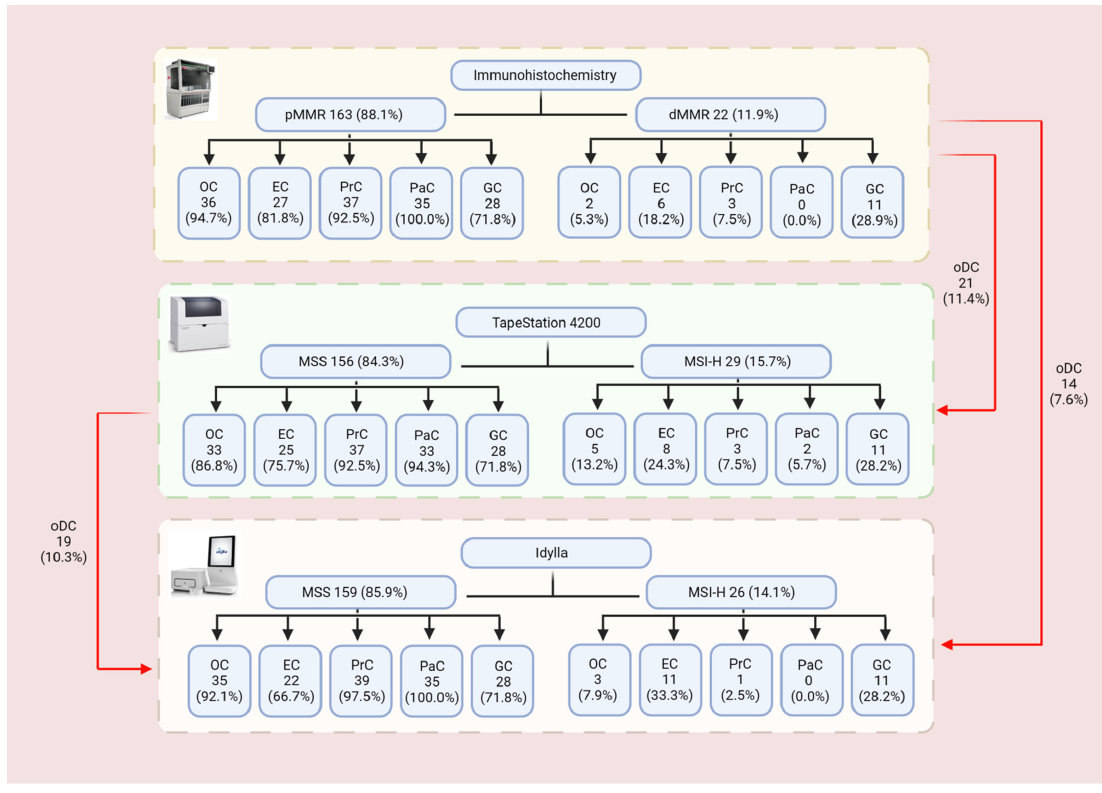
Figure 3. Flow chart summarizing results obtained with the three different assays. Abbreviations: dMMR: deficient mis- match repair; EC: endometrial cancer; GC: gastric cancer; MSI-H: high microsatellite instability; MSS: microsatellite stable;